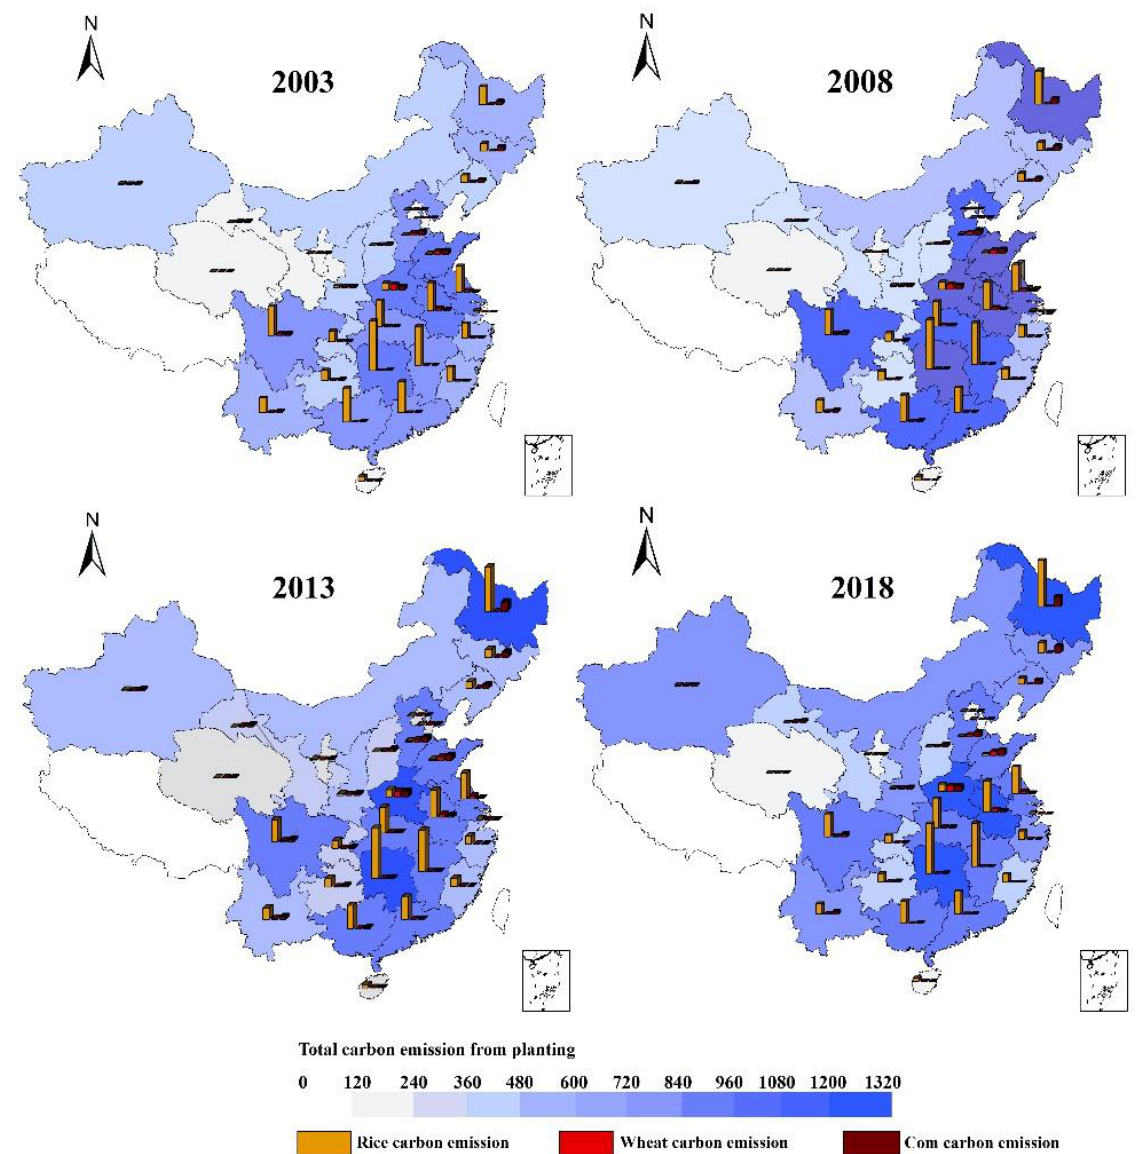
Figure 2. Planting carbon emissions of China in 2003, 2008, 2013, and 2018.